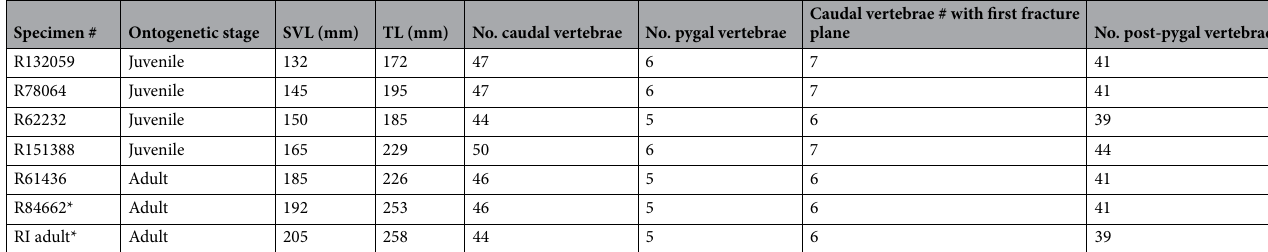
Table 1. Caudal vertebrae data for Egernia kingii specimens scanned by micro-CT. *R84662 tail was broken posthumously at caudal vertebrae vertebra #25, and RI adult tail was broken posthumously at caudal vertebra